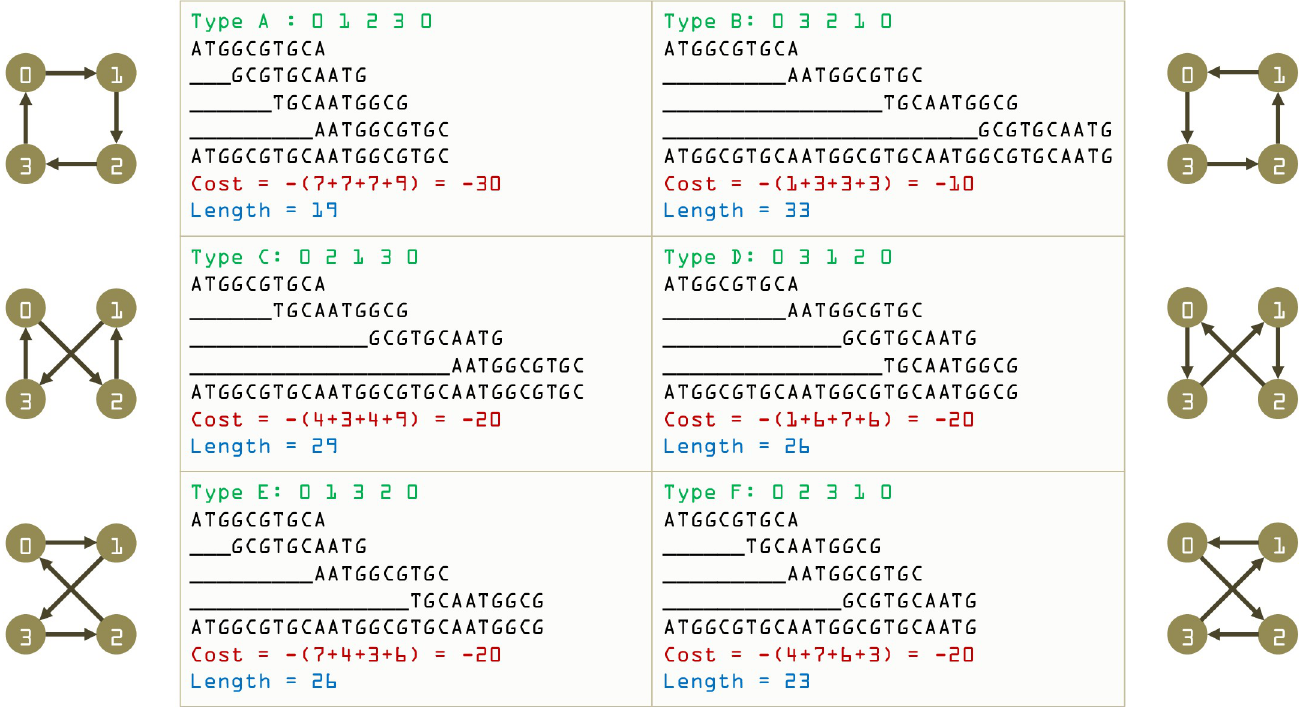
Fig 5. All possible TSP tours for given